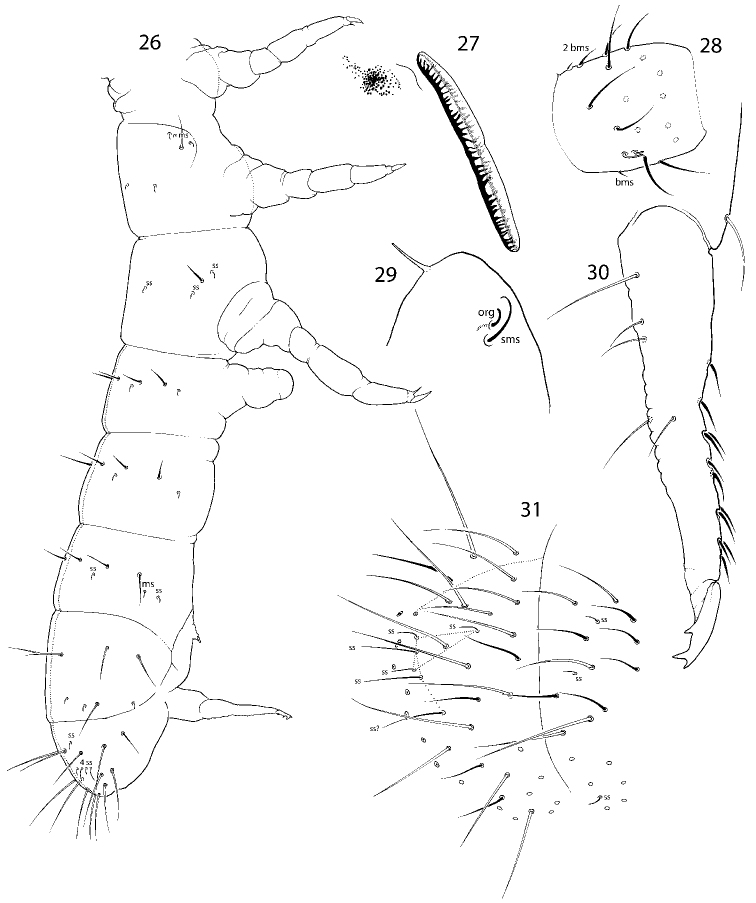
C.
postantennalis sp. nov. 26 macrochaetotaxy and s-ms-pattern 27PAO and eye area 28Ant. I 29 apical part of Ant. IV 30 dens, lateral view 31Abd. IV and V. Abbreviations: org organit, sms subapical ms-chaeta, ss s-chaeta, bms basal ms-chaeta, msms-chaeta.